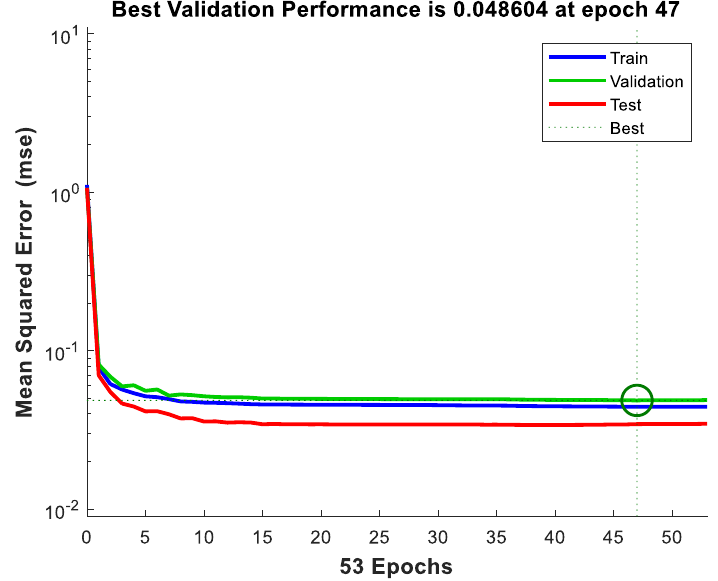
Figure 10. Training trajectory of the feed-forward, multilayer (1-23-12) ANN.